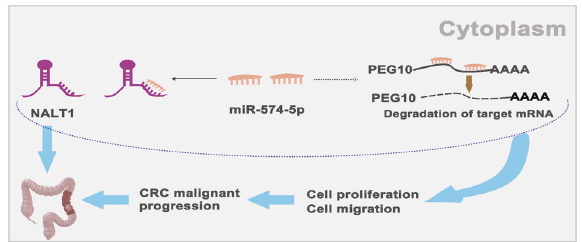
Fig. 9 Schematic representations of pathways modulated by NALT1 in CRC. NALT1 is upregulated in advanced-stage CRC and promotes CRC progression via a ceRNA pattern by sponging miR- 574-5p, which facilitates PEG10